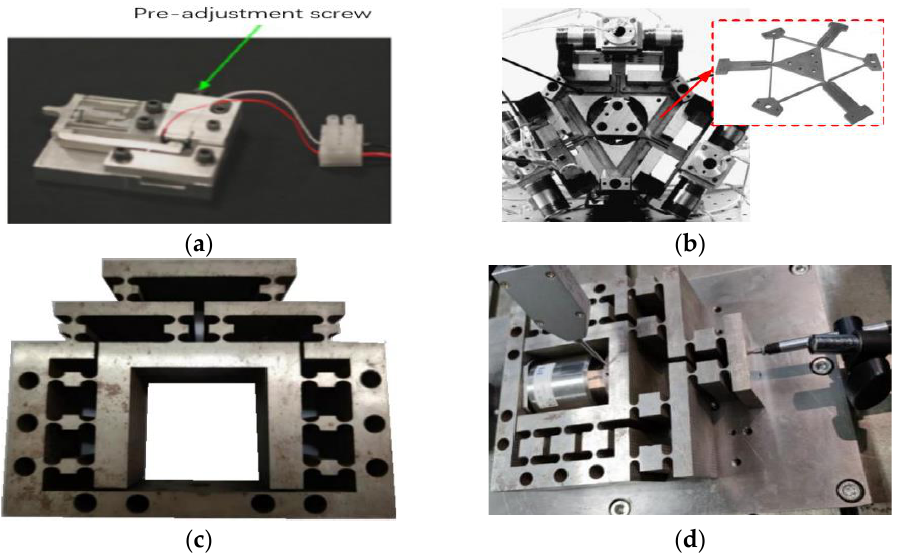
Figure 6. ( a ) Clamping mechanism. Reprinted with permission from ref. [66] Copyright 2009 Elsevier; ( b ) ultra-precision fiber alignment mechanism. Reprinted with permission from ref. [69] Copyright 2004 Elsevier; ( c ) micro-drive reduction mechanism [70]; ( d ) micro-drive amplification mechanism.